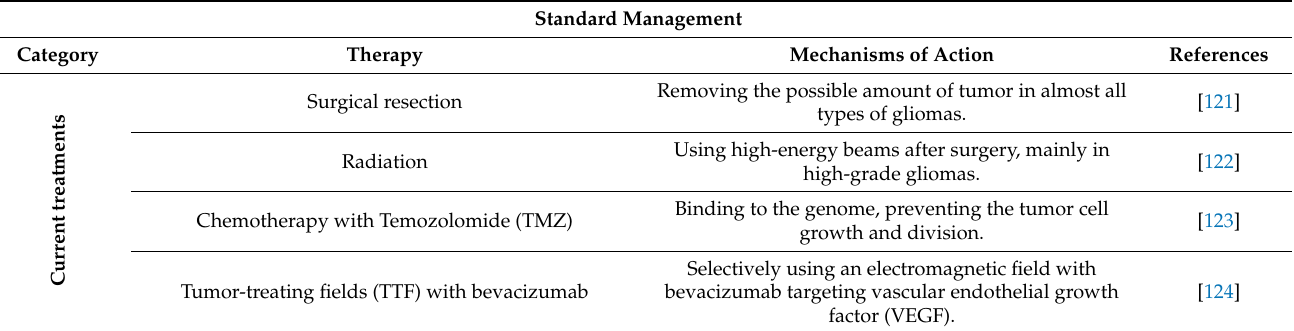
Table 1. Treatment strategies for GBM